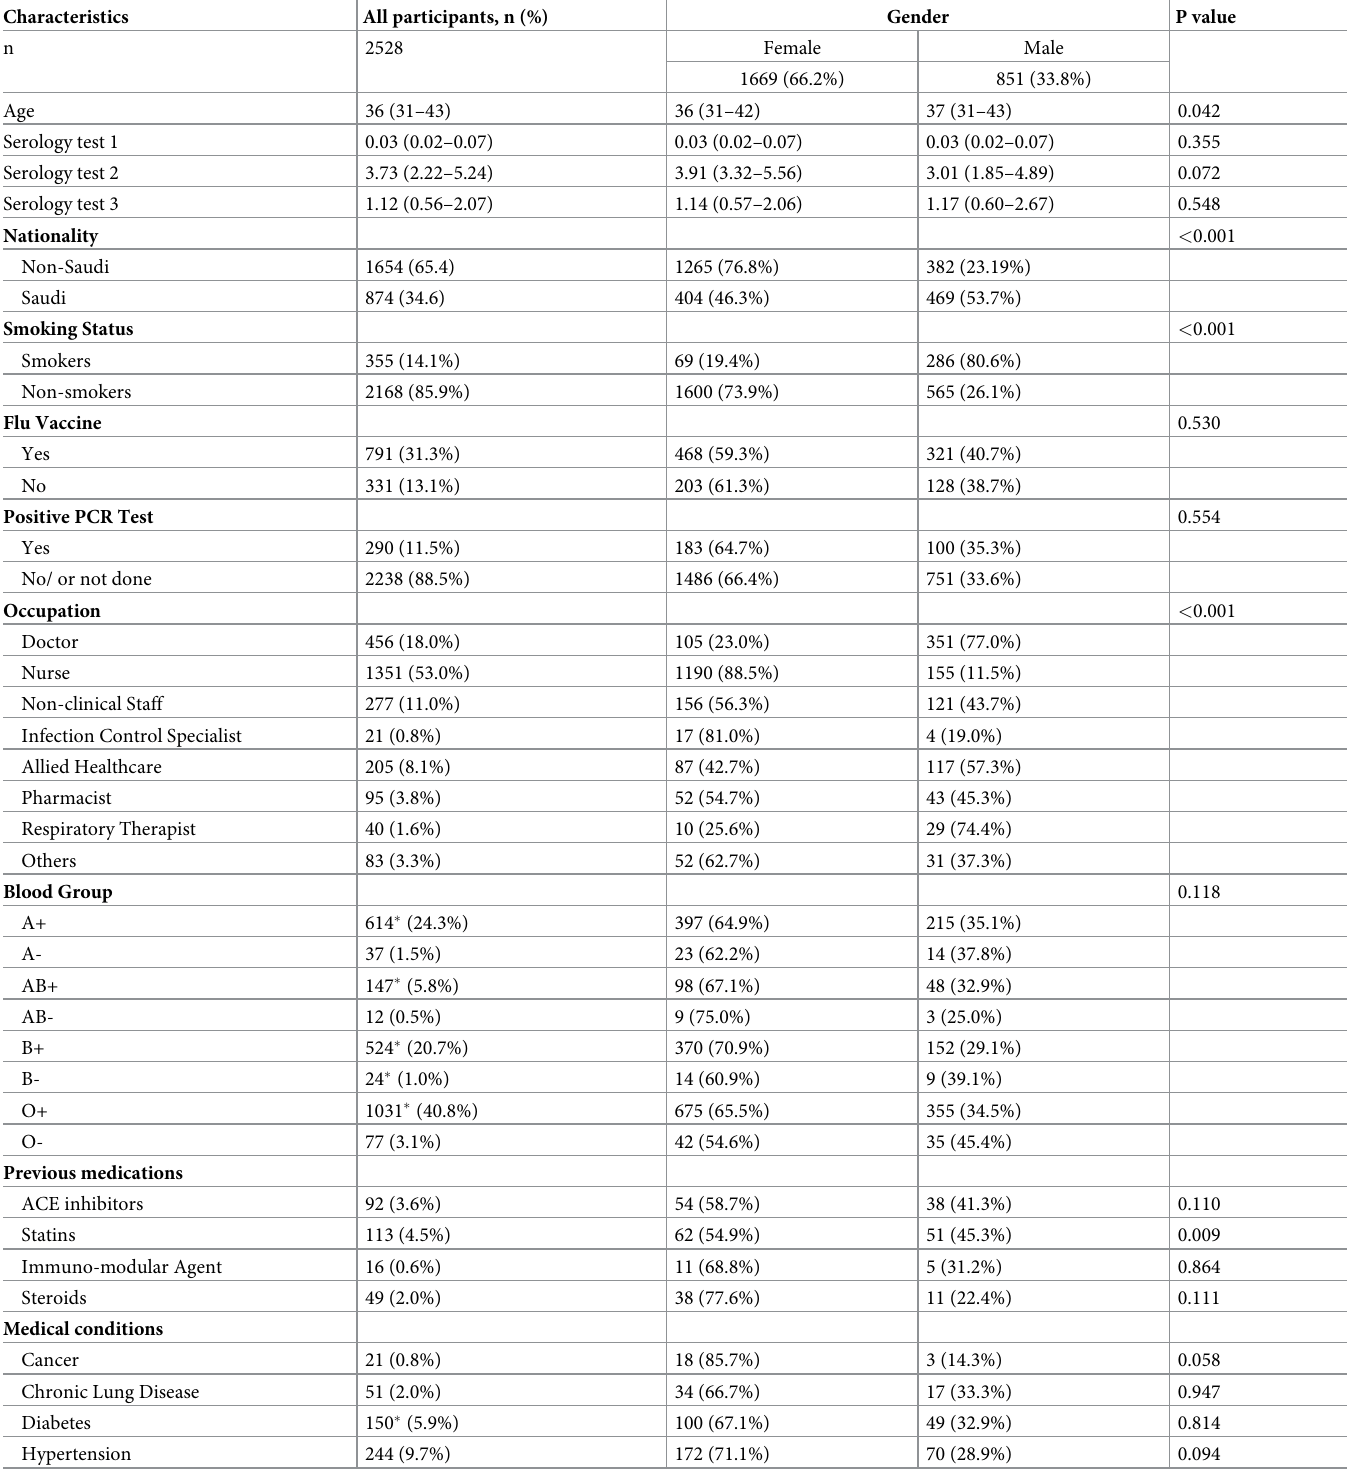
Table 2. Demographics and clinical characteristics of study participants by gender.